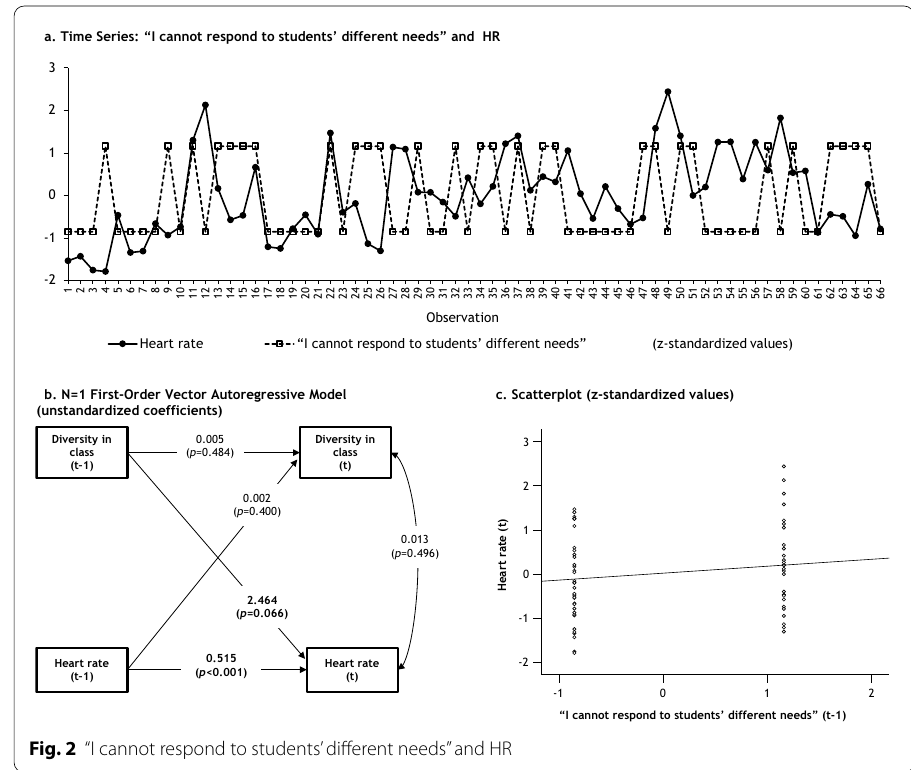
Fig. 2 “I cannot respond to students’ different needs” and HR